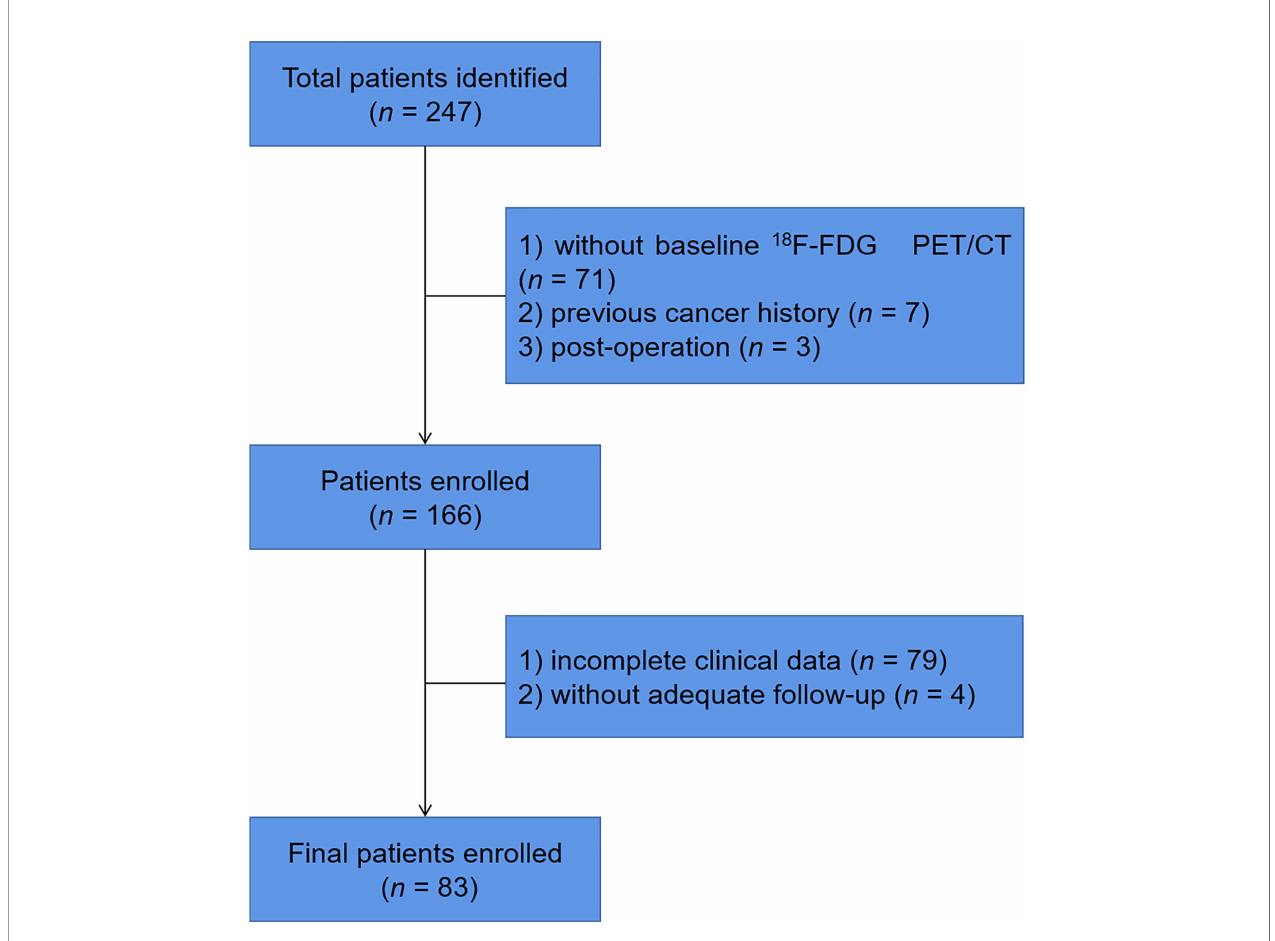
FIGURE 1 | Flow chart of patient selection and